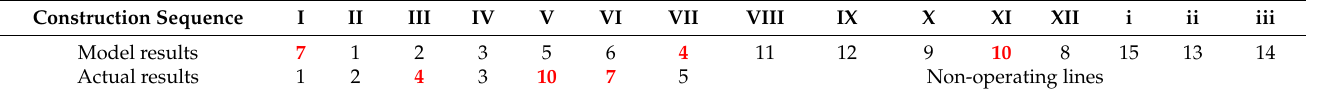
Table 9. Comparison of calculated and actual construction